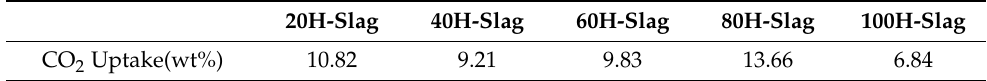
Figure 7. TG curves of (1) carbonated 20H-slag, (2) carbonated 40H-slag, (3) carbonated 60H-slag, (4) carbonated 80H-slag, and (5) carbonated 100H-slag. Table 5. CO 2 uptake of pretreated slags.